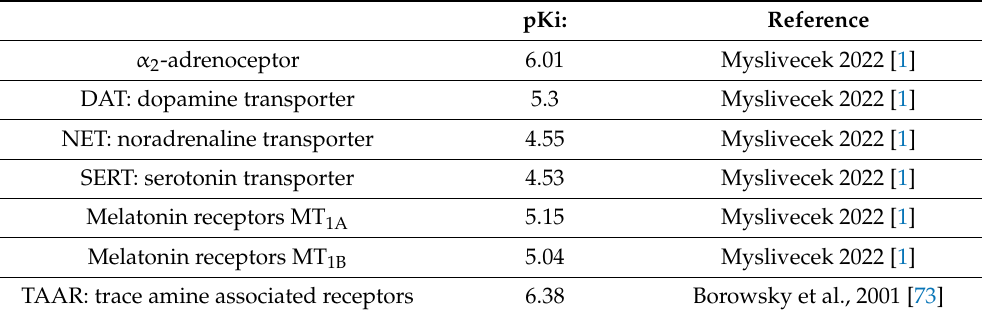
Table 4. Further dopamine binding receptors or other proteins: Dopamine does not only act on cardiac adrenergic receptors, as seen in Table 2, but dopamine can inhibit the transporter listed here or activate the receptors listed